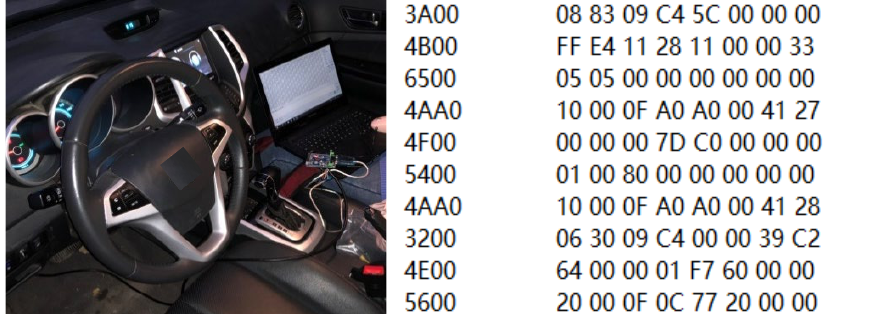
Figure 19. Collection and recording of bus data of a pure electric vehicle.